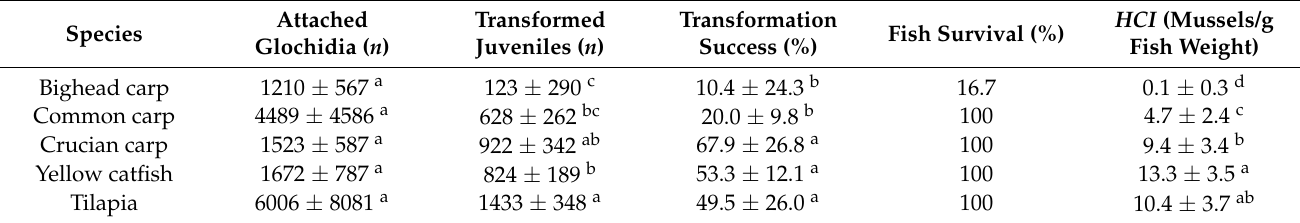
Table 2. Results of host capacity tests (mean ±